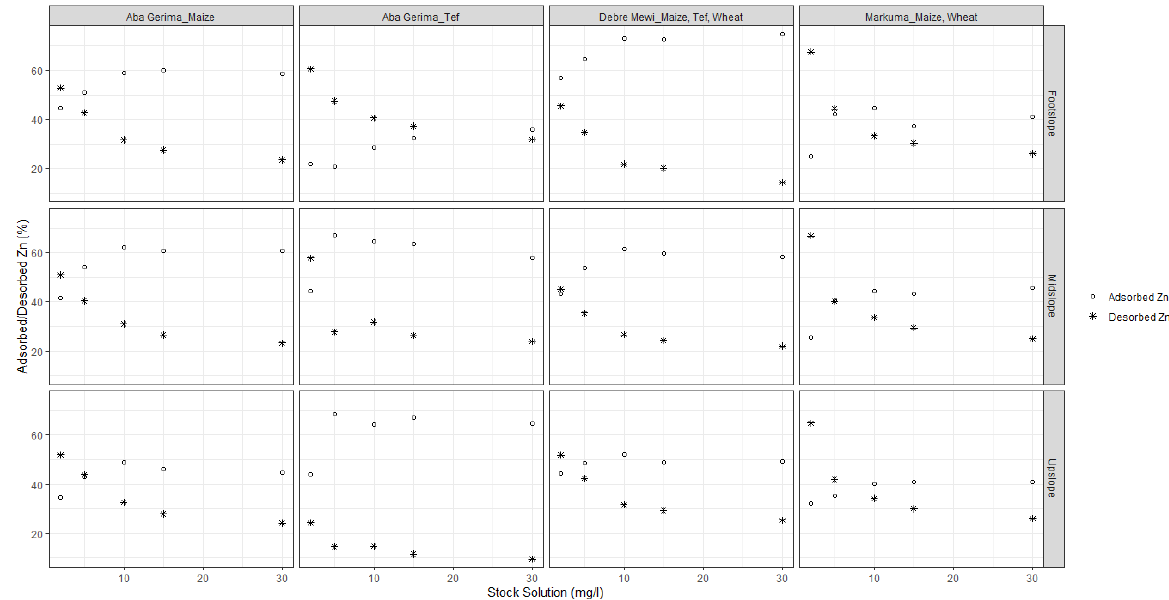
Figure 3. Percentage of adsorbed and desorbed Zn along the landscape positions. The separation factor R L ranges between 0 and 1 (Table 3) for all soils which indicates that the situation is favorable for reversible adsorption and desorption processes; a R L > 1 means that ad/des is not strong whereas values close to 0 indicate non-reversible pro- cesses. The separation factors generally decrease with increasing initial Zn concentrations for all locations and landscape positions. However, at the highest concentration of the stock solution (30 mg L − 1 ) the RL factor approaches 0.25 which might indicate a declining rate of desorption for all landscape positions (Figure 3). Table 3. Summary of the RL factor for adsorption and desorption. Landscape Posi- tion